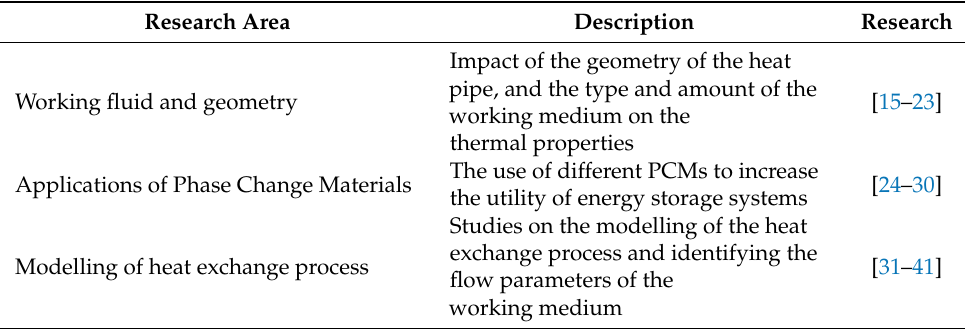
Table 1. Research efforts correlated to selected areas.